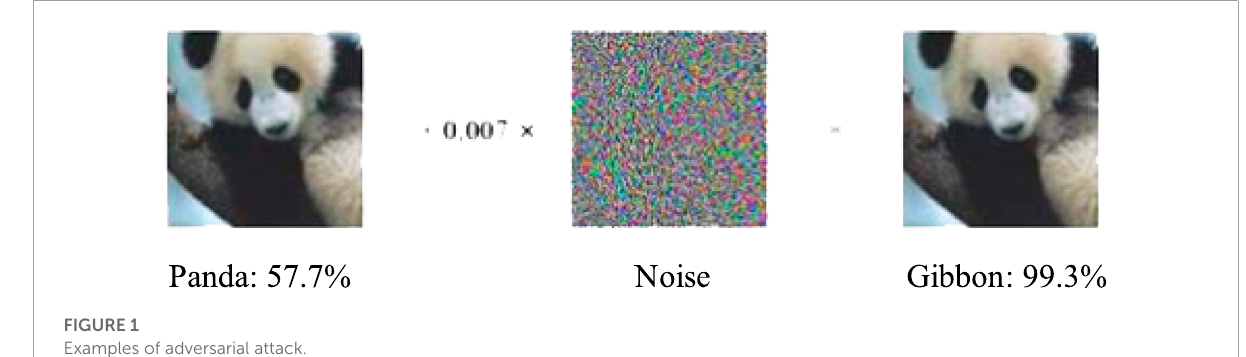
FIGURE 1 Examples of adversarial